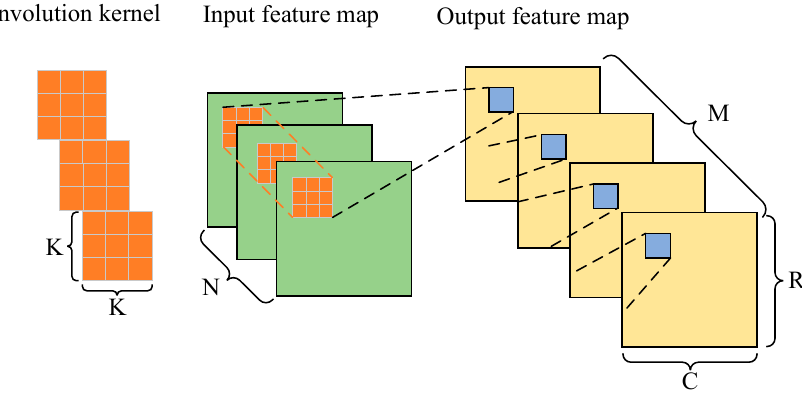
Figure 7. Convolution layer computation.